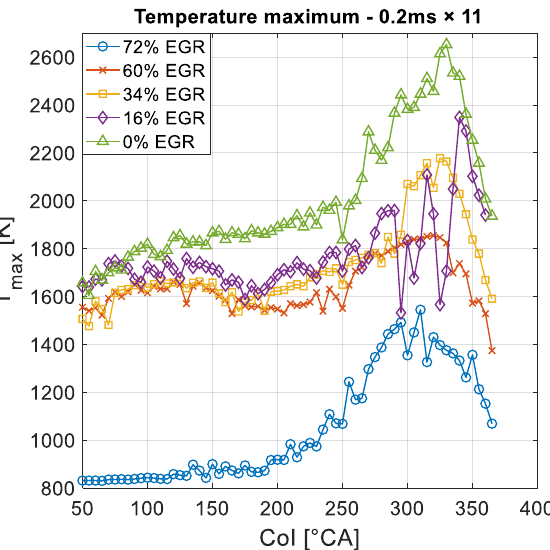
Figure 18. The temperature maxima of the 0.2 ms × 11 structure with different EGR rates in the function of CoI.